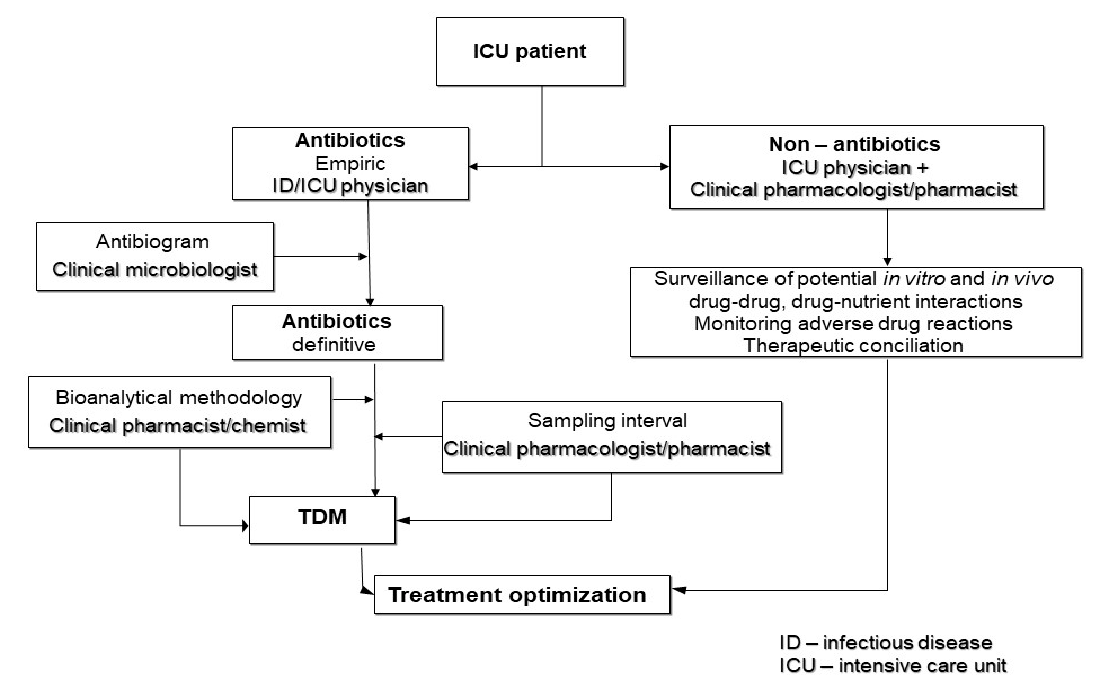
Figure 2. Decision ‐ making steps of optimization of therapy in septic critically ill patients [78,79]. Figure 2. Decision-making steps of optimization of therapy in septic critically ill patients